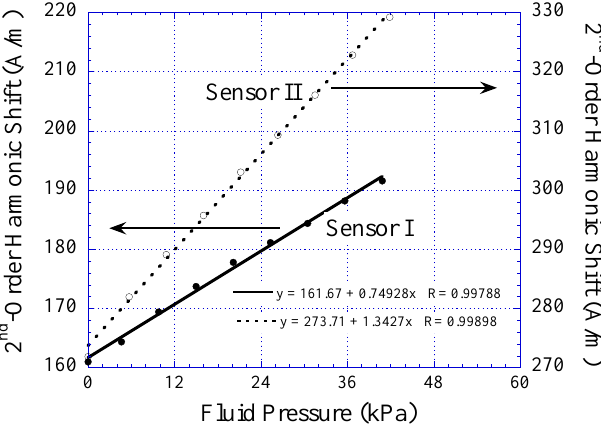
Figure 10. The 2nd-order harmonic shift obtained from Sensor I and II when exposed to varying fluid pressure. Both the sensors exhibited linear signal response with detection sensitivity of 0.749 and 1.34 A/m∙kPa,